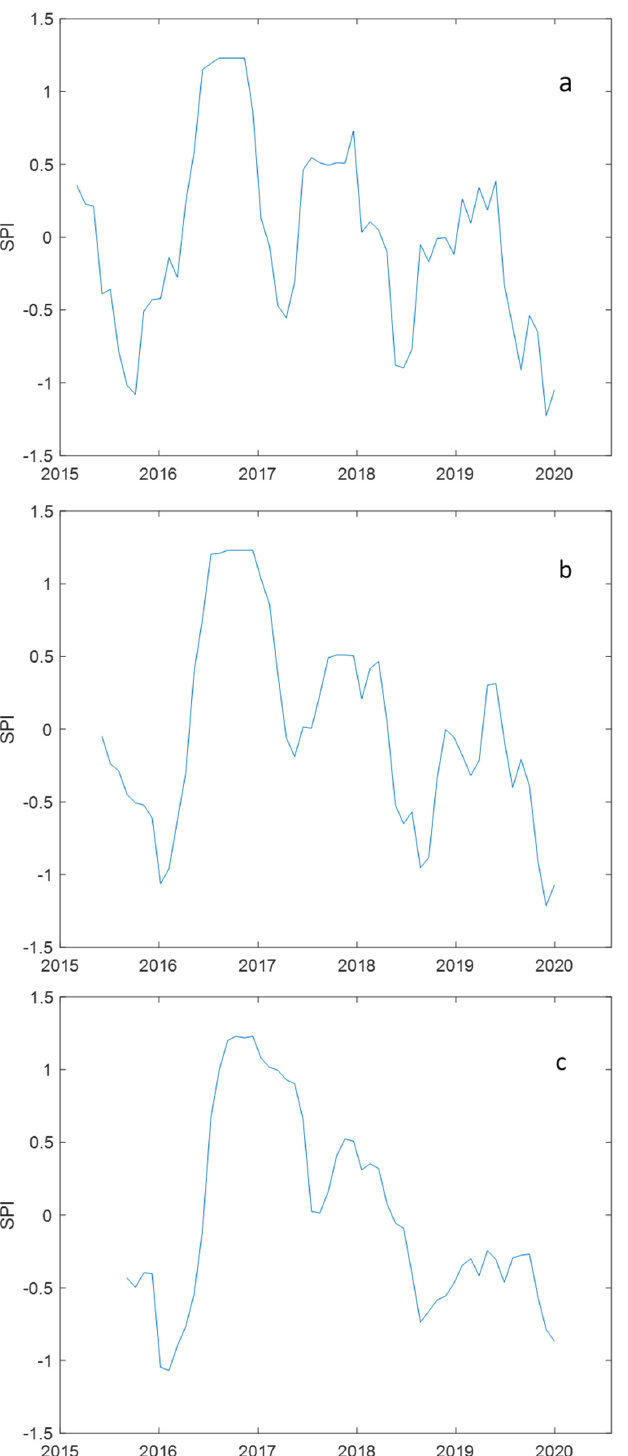
Figure 2. Regional SPI time series from 2015–2019 TRMM monthly data in Java: ( a ) SPI 3, ( b ) SPI 6, and ( c ) SPI 9.